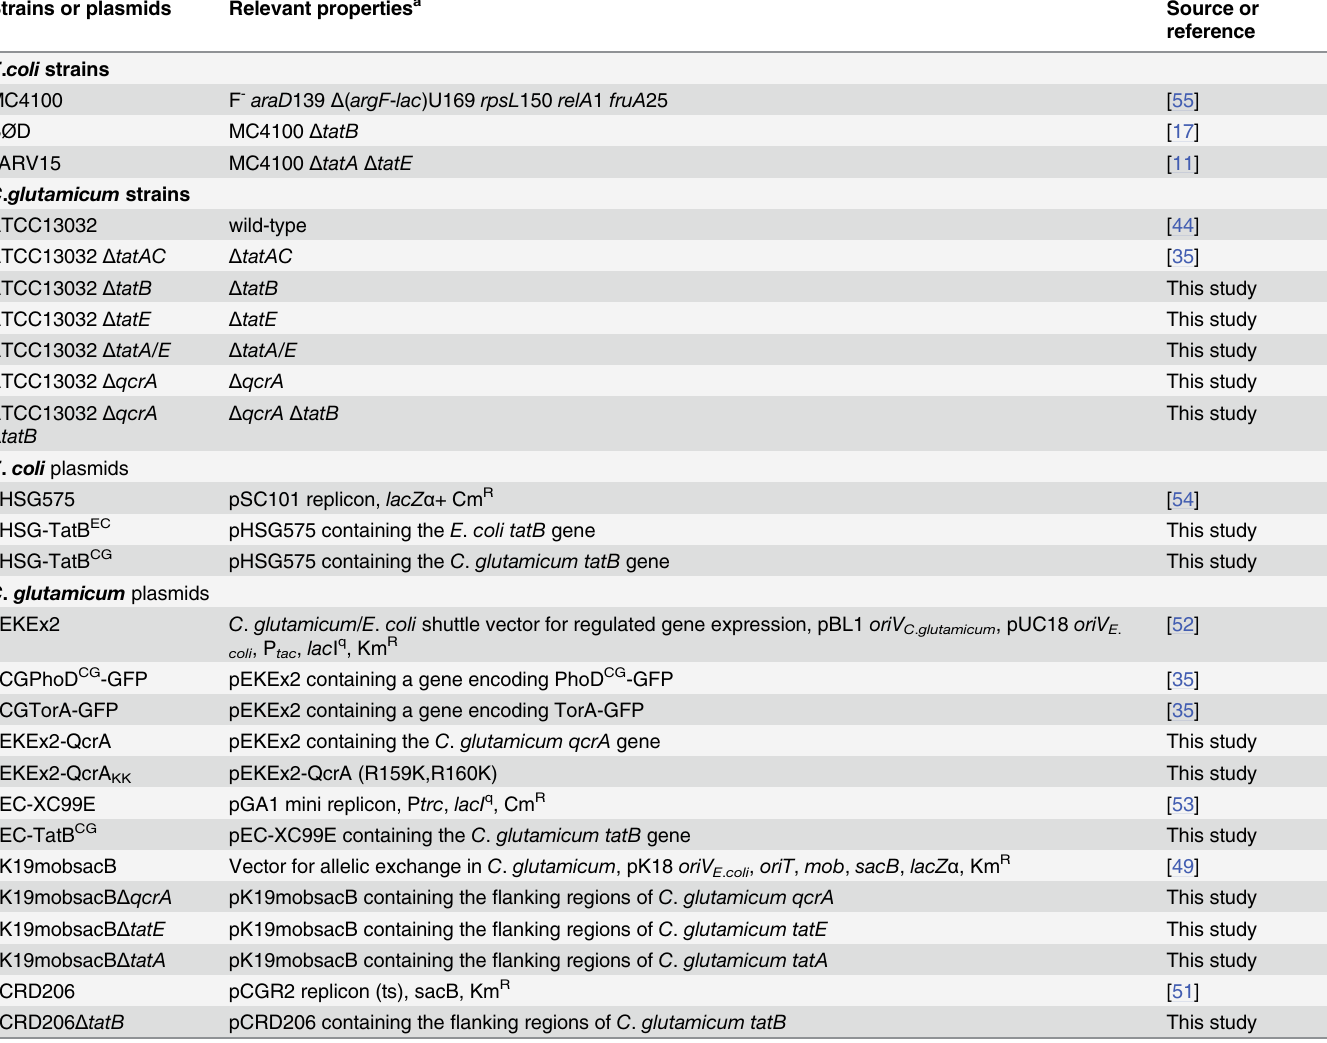
Table 1. Bacterial strains and plasmids used in this